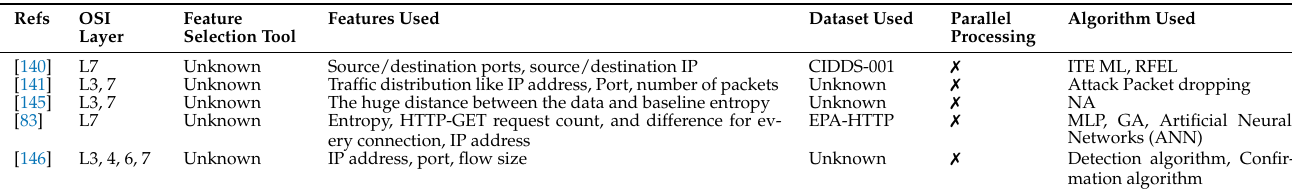
Table 14. Entropy-based DDoS detection approaches.